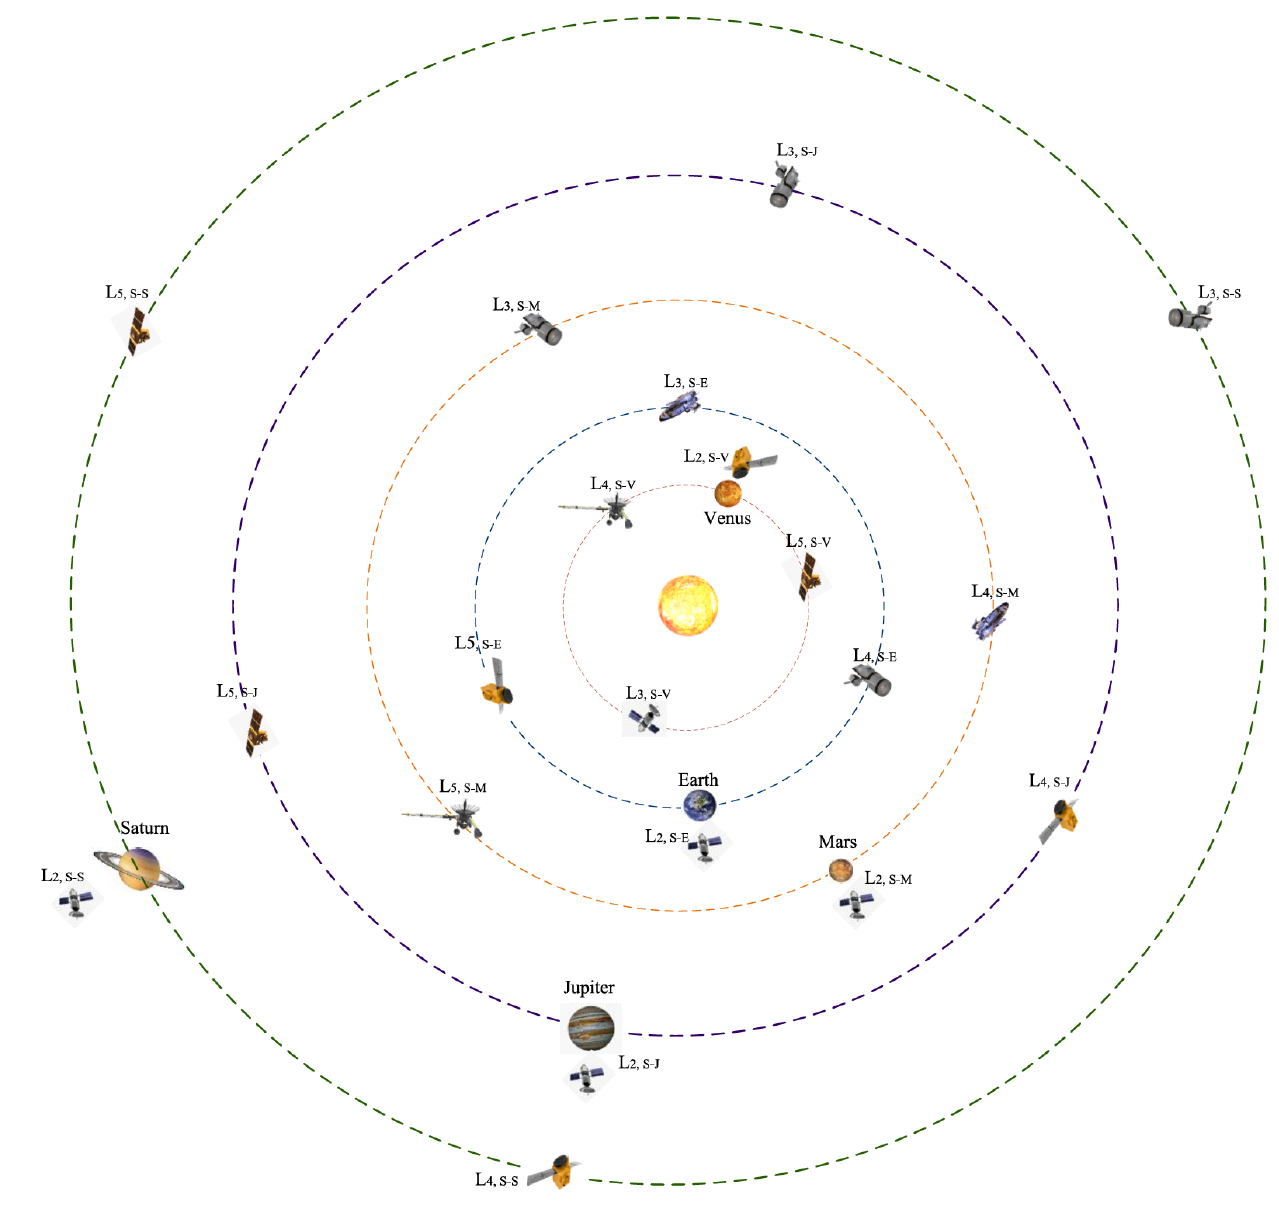
Figure 17. An exemplary illustration of survey stations and spacecraft deployed under the SCADN framework; in particular, the survey stations/spacecraft are deployed at Lagrange points of the solar planets (dimensions of orbits, planets and spacecraft are not